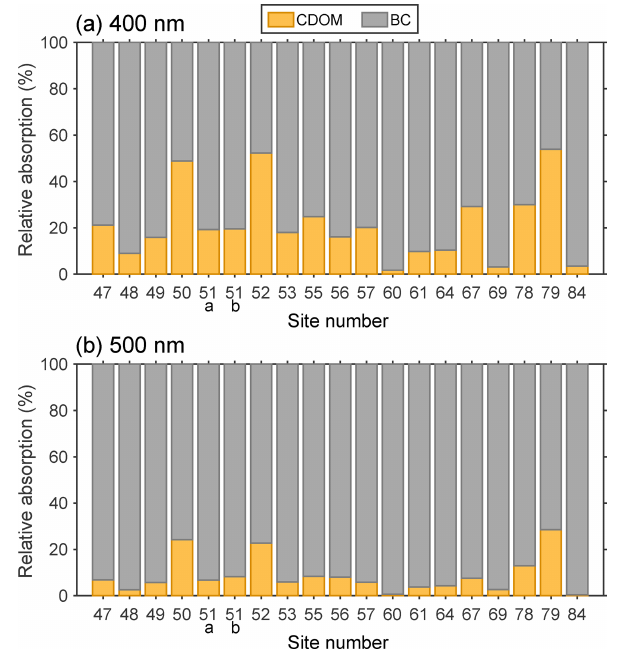
Figure 11. Relative absorption contributions of CDOM and BC at (a) 400nm and (b)